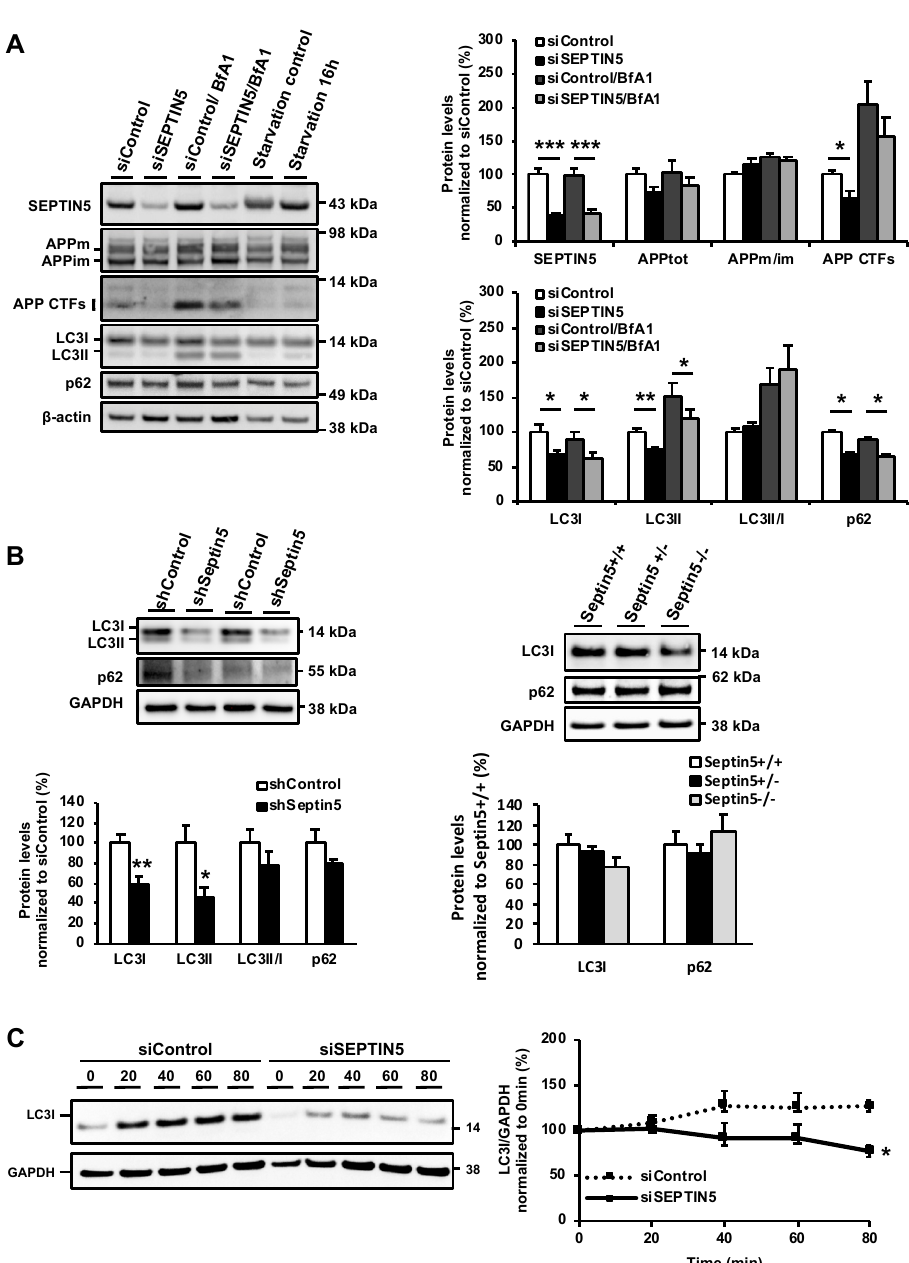
Figure 4. APP CTFs are degraded via the autophagosomal pathway and the downregulation of SEPTIN5 enhances autophagosomal activity in SH-SY5Y-APP751 cells. ( A ) Western blot analysis of SH-SY5Y-APP751 cells transfected with SEPTIN5 siRNA or control siRNA and treated with 200 ng/mL BfA1 or vehicle. Additionally, protein levels from serum-starved (16 h) and starvation control (normal culture medium containing 10% FBS) in SH-SY5Y-APP751 cells were used as controls. Protein levels were normalized to β -actin and are shown as a % of siControl, n = 7, mean ± SEM, independent t-test, * p < 0.05, ** p < 0.01, *** p < 0.01; ( B ) Western blot analysis of LC3I, LC3II, and p62 in mouse primary cortical neurons transduced with Septin5 shRNA and in Septin5 +/+ , Septin5 +/ − , and Septin5 − / − mice. Protein levels were normalized to GAPDH and are shown as a % of siControl or Septin +/+ mean ± SEM. Independent t -test, * p < 0.05, ** p < 0.01, *** p < 0.01 (left figure). One-way ANOVA, post-hoc LSD (right figure); ( C ) Western blot analysis of LC3I in SH-SY5Y-APP751 cells transfected with SEPTIN5 siRNA and treated with 30 µ g / mL cycloheximide for 0, 20, 40, 60, and 80 min, n = 4, SEM, two-way repeated measures ANOVA, post hoc Tukey HSD. * p < 0.05.